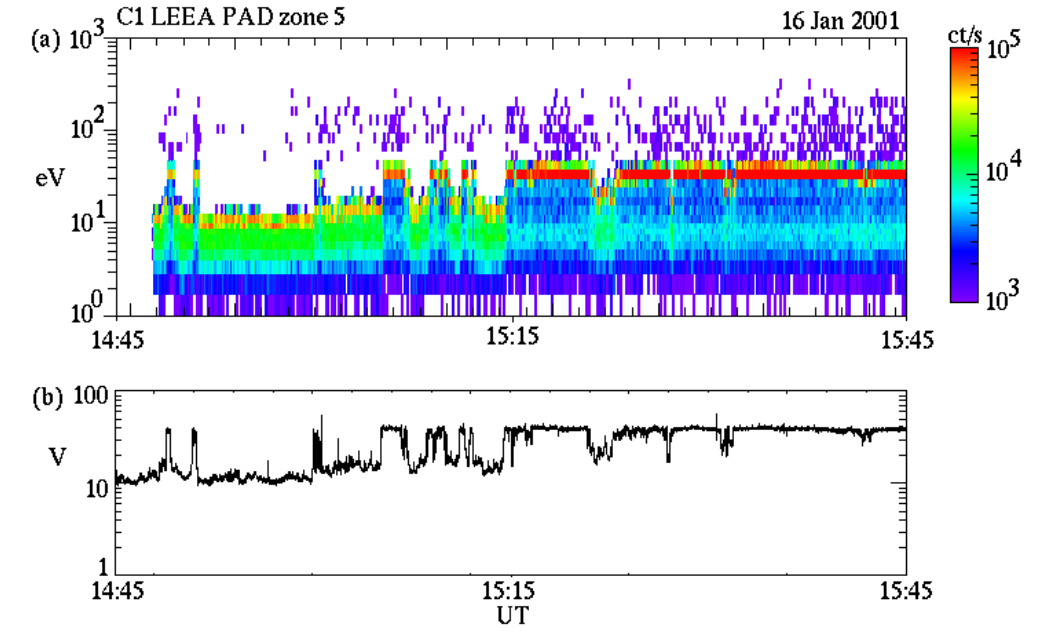
Fig. 3. Spacecraft 1 data from 16 January 2001 showing spacecraft electrons in a low density environment (a) PEACE LEEA data (b) EFW data showing spacecraft